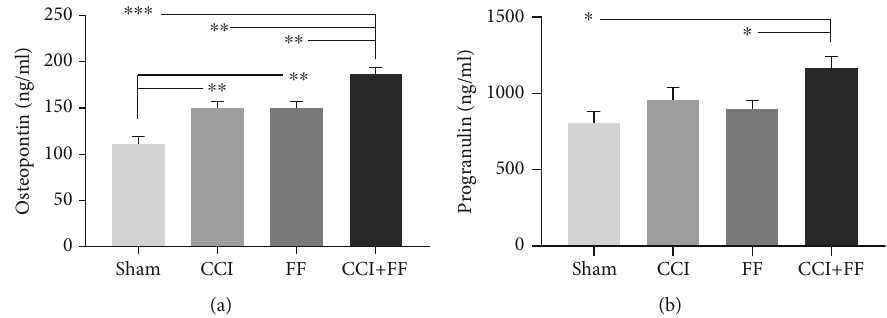
Figure 6: Combined injury increases plasma levels of the in fl ammatory and repair biomarkers osteopontin and progranulin. (a, b) Osteopontin and progranulin protein plasma concentrations as determined by ELISA at 5 dpi. Osteopontin was increased in CCI+FF mice compared to all other groups and in the CCI and FF groups in comparison to sham. Progranulin was increased in CCI+FF mice in comparison to sham and FF. Values represent mean ± SEM ; p values were calculated using Holm-Sidak ’ s multiple comparison